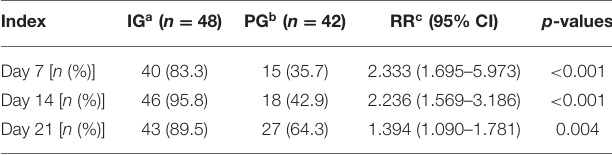
TABLE 2 | Number of responders to the